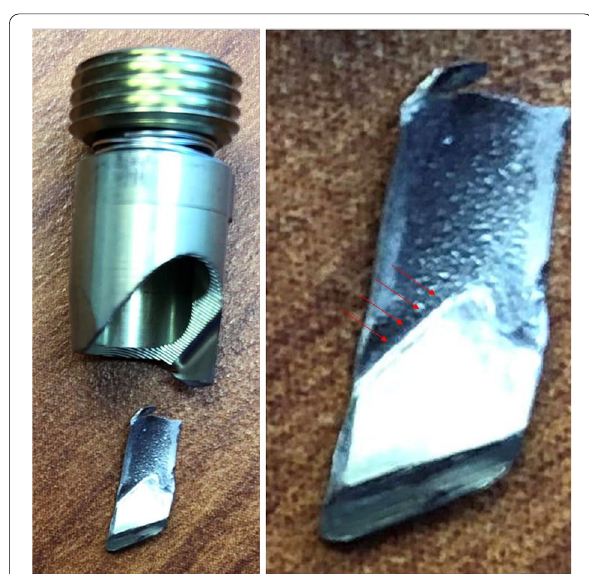
Fig. 3 A fractured set screw for the TFNa was discovered after removal and disassembly of the implant. Arrows point to engaging defect of the long prong with corresponding lesions on the helical blade consistent with fracture of the prong by the edge of the